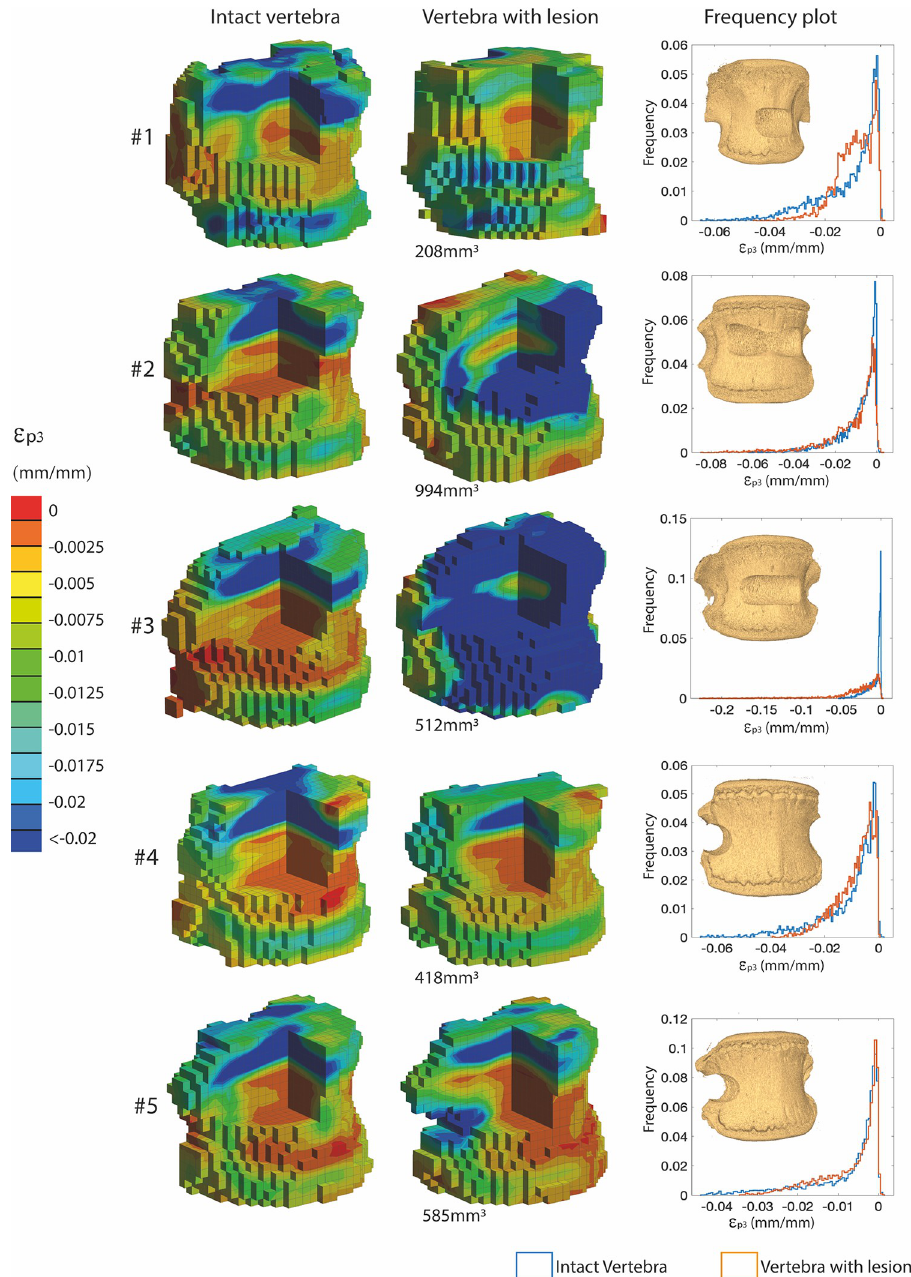
Fig 4. ε p3 distributions in the intact vertebrae (left) and in the vertebrae with artificial lesions (middle). The volume of the lesion is reported close to the strain distributions for vertebrae with defects. On the right, rendering of the vertebra with the created artificial lesion and frequency plots for ε p3 in the whole vertebral body with (orange) and without (blue) the lesions are reported. For the intact vertebrae, the larger strains localized in correspondence of the growth plates, both on the top and the bottom. For the vertebrae with the artificial lesions, the strain distribution was different and strain concentrations were visible around the lesion. The tests on the vertebrae with lesions (volume between 208mm 3 and 994mm 3 , corre- sponding to the 0.8% and 4.6% of the volume of the vertebral body, Fig 4) showed an increase of the strain in proximity of the lesion and a decrease of the strain in the growth plate regions.